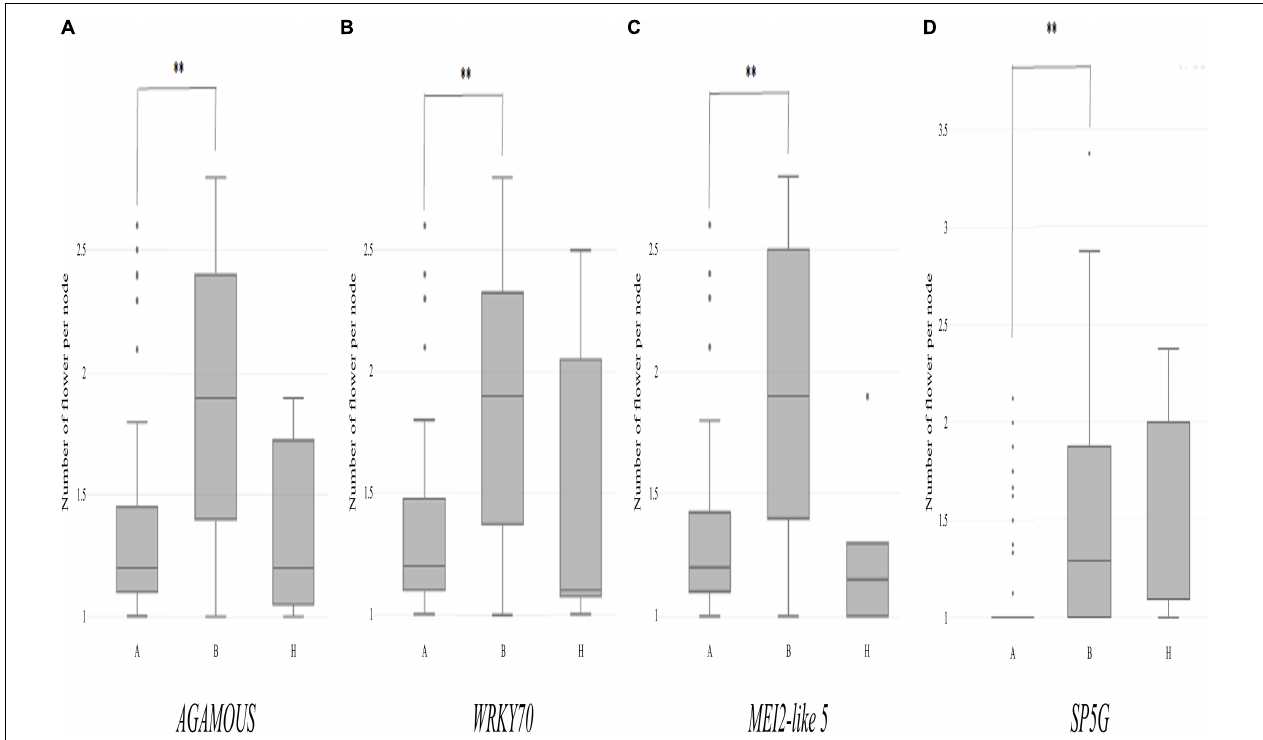
FIGURE 8 | Distribution of the variation measured in the multiple-flowers-per-node trait associated with the genotypes of individual candidate genes in the TH RIL (A–C) and CSHL (D) populations. TH RILs were classified based on the genotype of the bin marker most closely linked to the target genes. CSHL C. annuum clade accessions were genotyped at the SP5G gene with the SP5G SCAR marker. Asterisks indicate significant differences ∗∗ P < 0.01. P -values were determined by a two-tailed, two-sample t